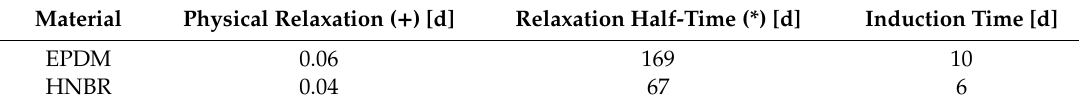
Table 2. Characteristic times determined in continuous stress relaxation measurements (cf. Figure